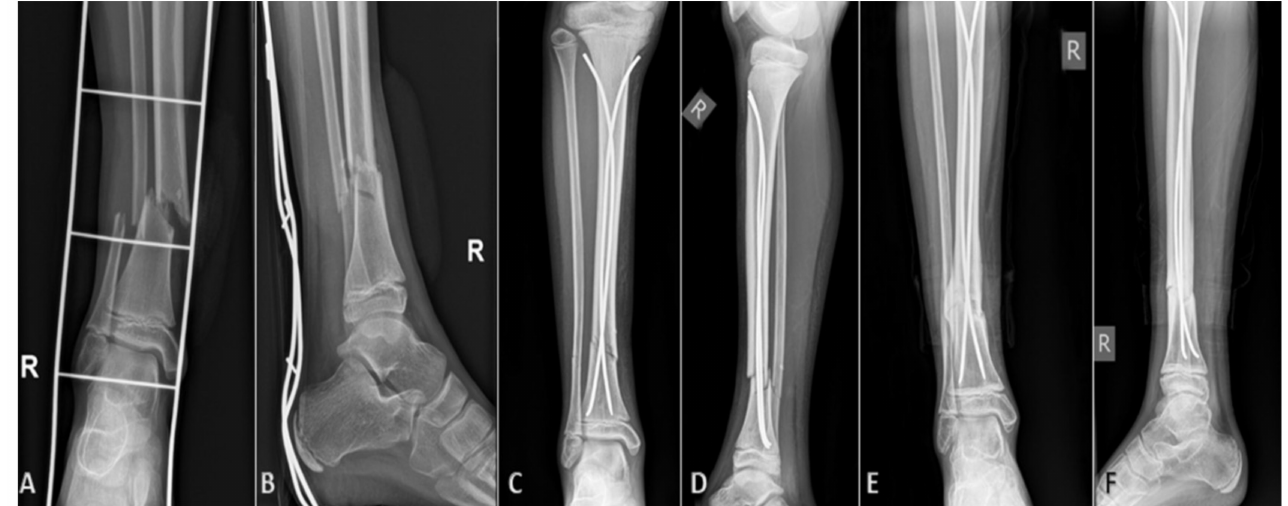
Figure 2. Displaced distal tibial fracture in 9-year-old male patient: ( A ) preoperative AP radiograph; ( B ) preoperative LL radiograph; ( C ) AP radiograph one month after surgery; ( D ) LL radiograph one month after surgery; ( E ) AP radiograph three months after surgery; ( F ) LL radiograph three months after